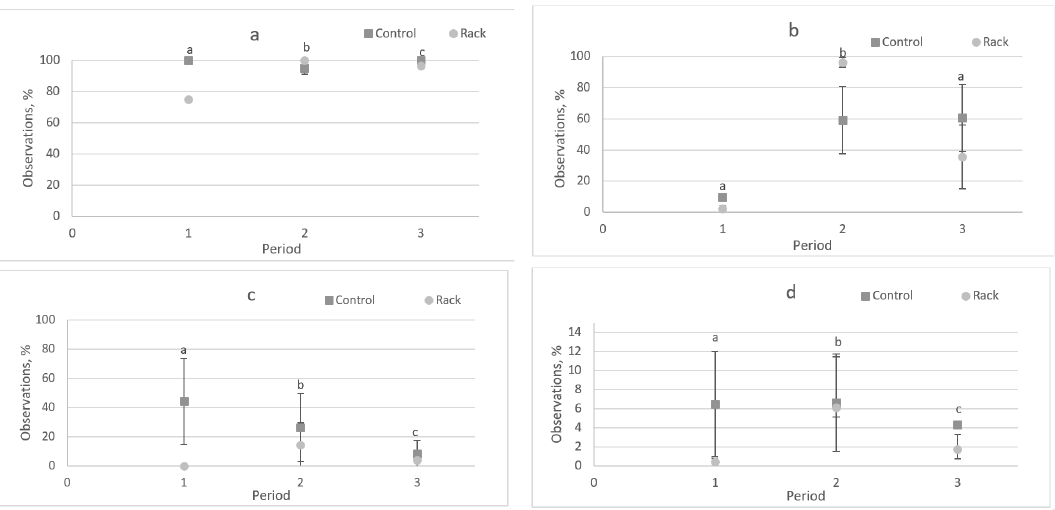
Figure 7. Amounts of clean straw during different periods. Different letters above period mean indicate significant difference between periods. Different letters above indicate significant difference between different periods. ( a ) Levels of amount of clean straw on the floor exceeding level 1 (score 1–4) over time. The period and the interaction between treatment and period had a significant effect ( N = 44,012). ( b ) Levels of observations of amount of clean straw on the floor exceeding level 2 (2–4) over time. The period and the interaction between treatment and period had a significant effect ( N = 44,012). ( c ) Levels of observations of amount of clean straw on the floor exceeding level 3 (score 3–4) over time. The period and the interaction between treatment and period had a significant effect ( N = 44,012). ( d ) Levels of observations of amount of clean straw on the floor exceeding level 4 over time. The period and the interaction between treatment and period had a significant effect ( N =